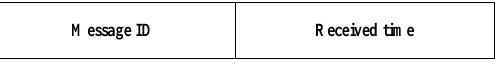
Figure 1. One entry of Acknowledge